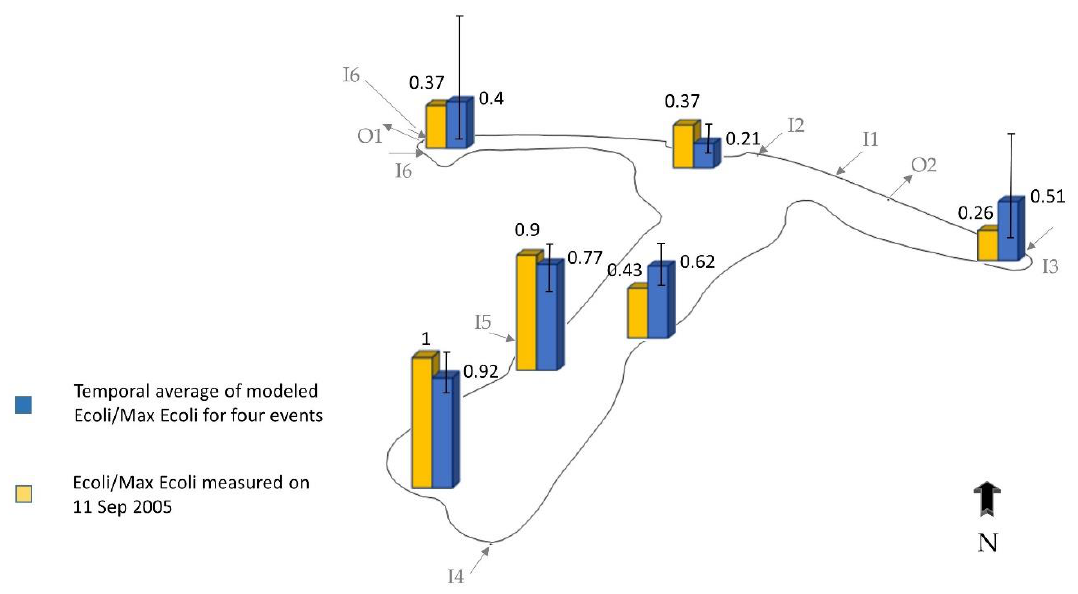
Figure 10. Non-dimensional E.coli concentration 15 cm below the surface.